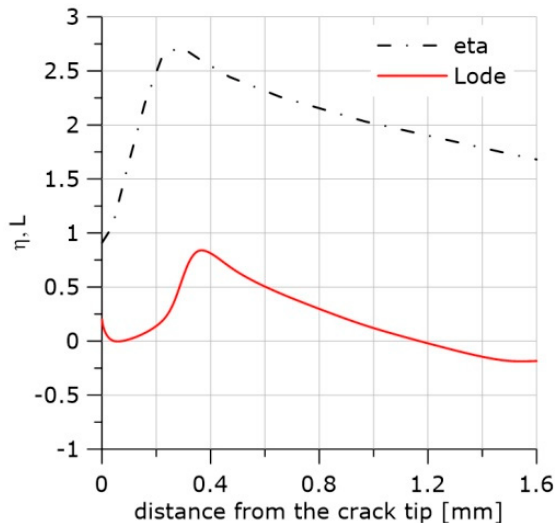
Figure 14. Distributions of the η and Lode functions at the crack center at the moment when the loading was stopped, specimen PR and the material softening option, material NW, temperature − 50 °C.